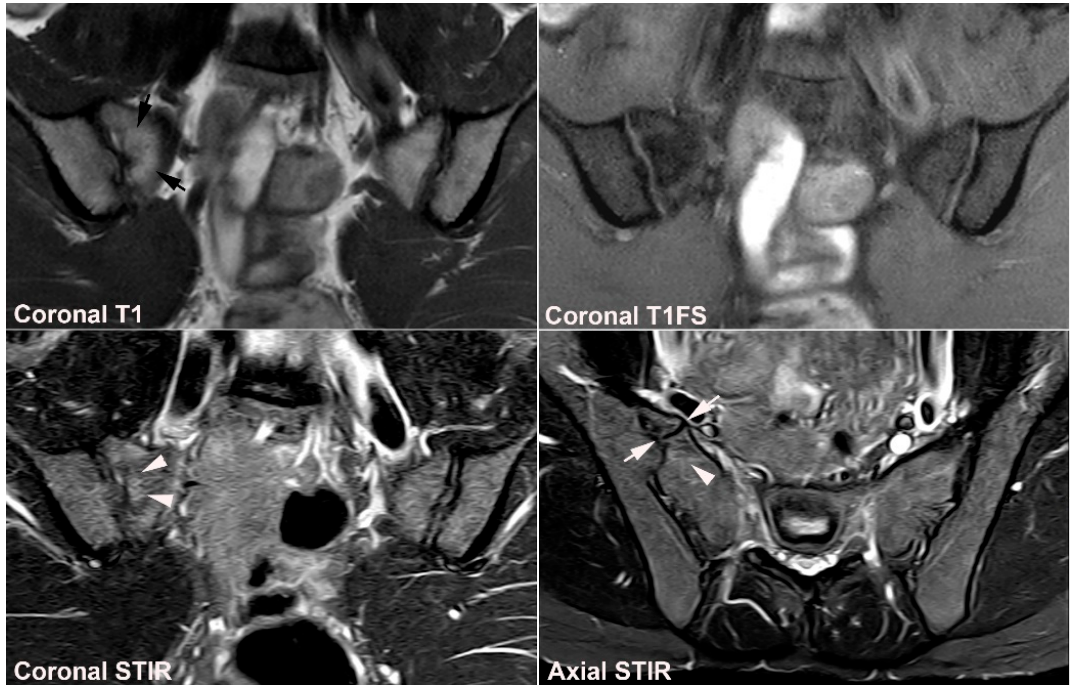
Figure 12. Atypical fusion of nucleus in a 24-year-old man with right-sided buttock pain for 8 months. Semi-coronal T1, T1FS and STIR, and semi-axial STIR images at the border between S1 and S2. At the right SIJ there is a relative hypertrophic nucleus at the border between S1 and S2 which has fused with the ileum and not as normally with the sacral bone (white arrows). It causes an indentation in the sacral bone with a surrounding brim of edema (arrowheads), focal irregular joint margins and fat deposition (black arrows on T1).